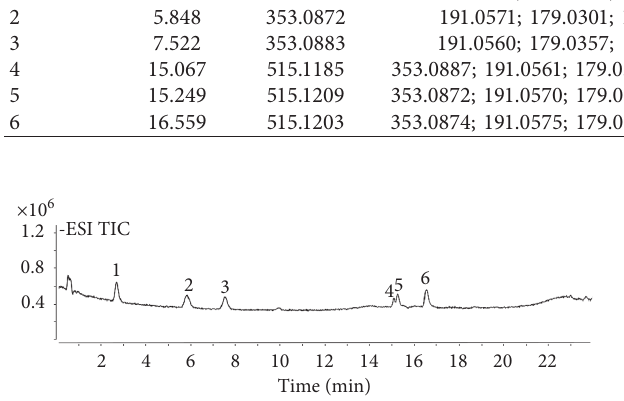
Figure 4: UHPLC/Q-TOF-MS chromatography of main active components from RDN injection. 1: neochlorogenic acid; 2: chlorogenic acid; 3: cryptochlorogenic acid; 4: isochlorogenic acid B; 5: isochlorogenic acid A; and 6: isochlorogenic acid